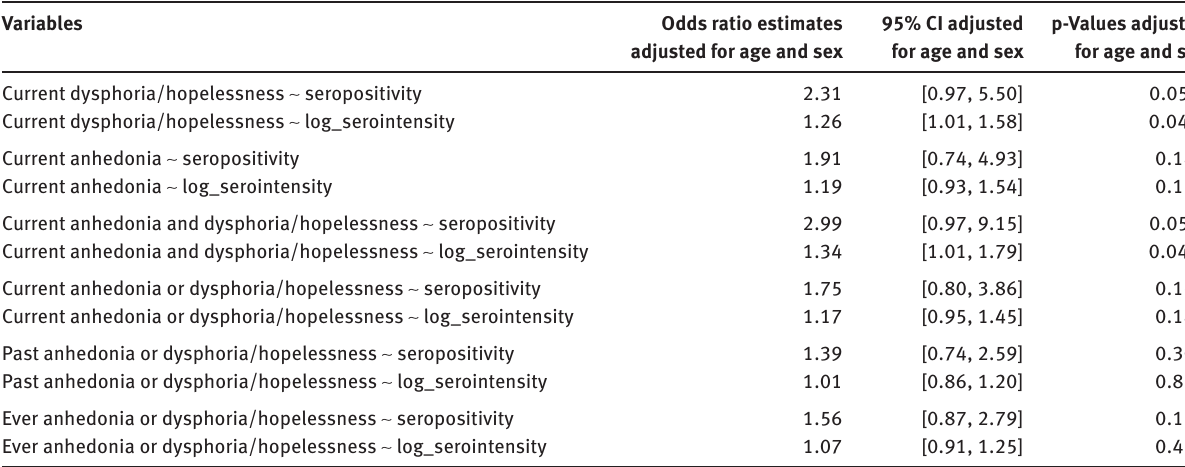
p-Values, odds ratio estimates and confidence intervals, generated by multi-variable logistic regression models with the presence of symp- toms of depression as dependent variables and T. gondii seropositivity and serointensity as independent variables, accounting for sex and age. a Statistical trend (p < 0.10). b Significant (p < 0.05). ~ , related